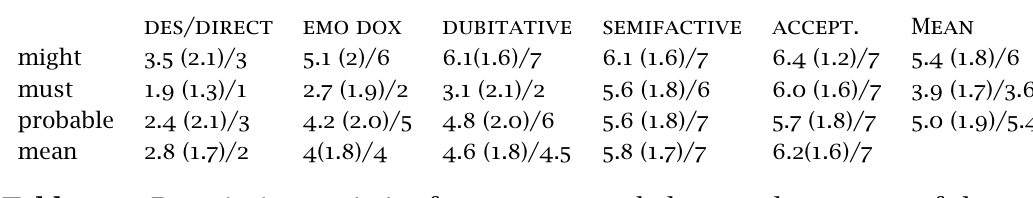
Descriptive statistics for surveys, pooled across languages, of the form mean (standard